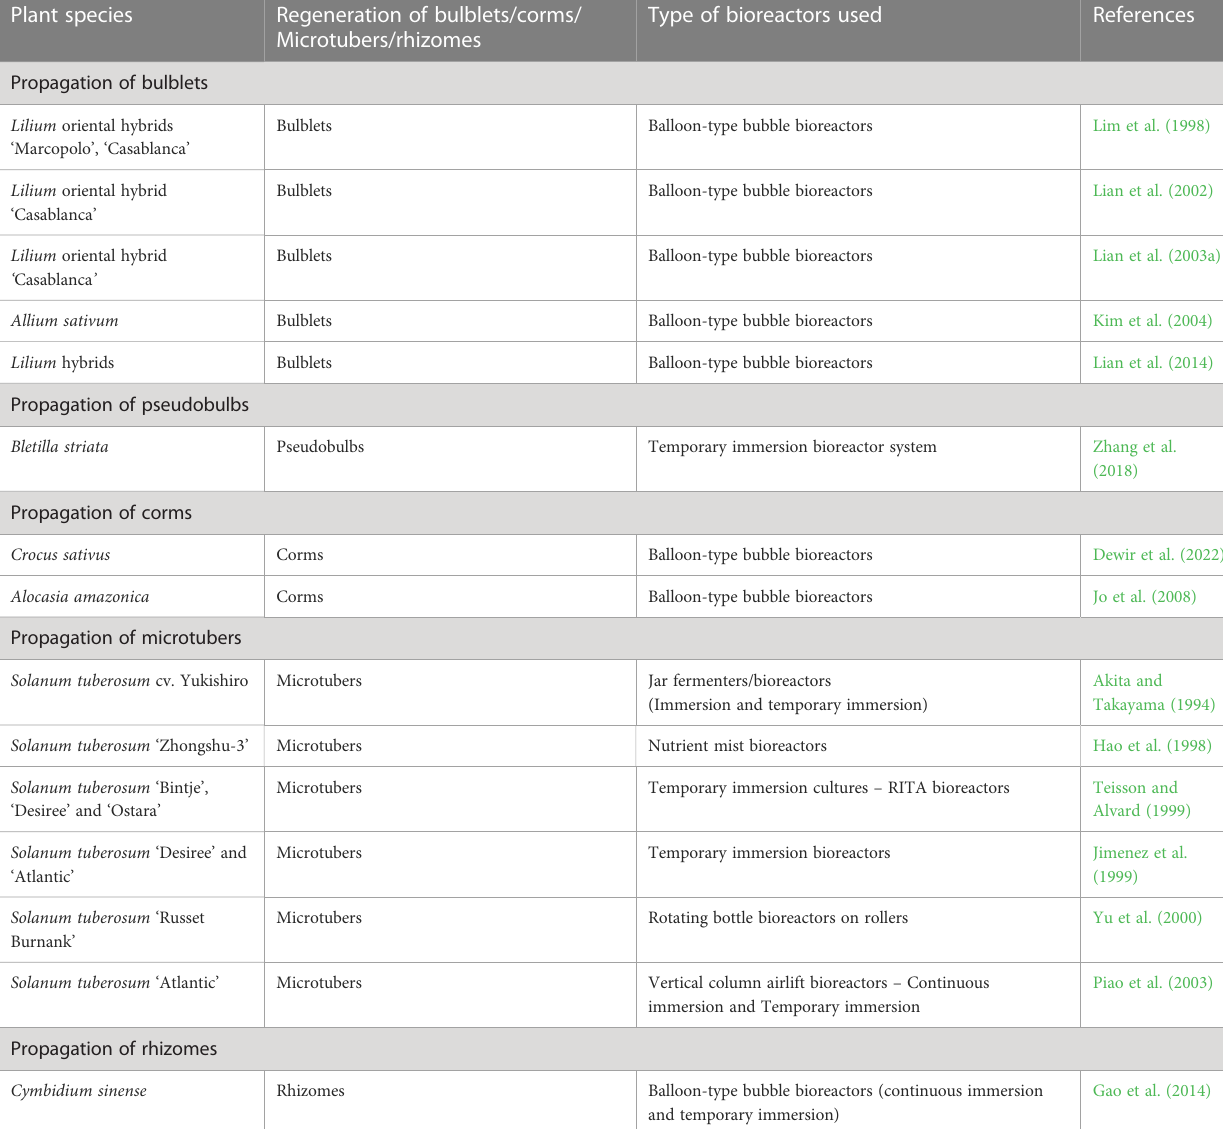
TABLE 2 Selected examples of propagation of bulblets, corms, microtubers, and rhizomes in bioreactor